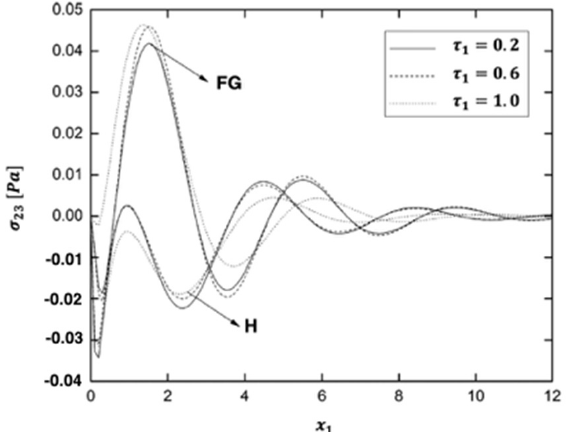
Figure 18. Variation of the thermal stress wave σ 23 along x 1 − axis in the functionally graded (FG) and homogeneous (H) anisotropic fiber-reinforced plates under different values of time characteristic of the laser pulse.